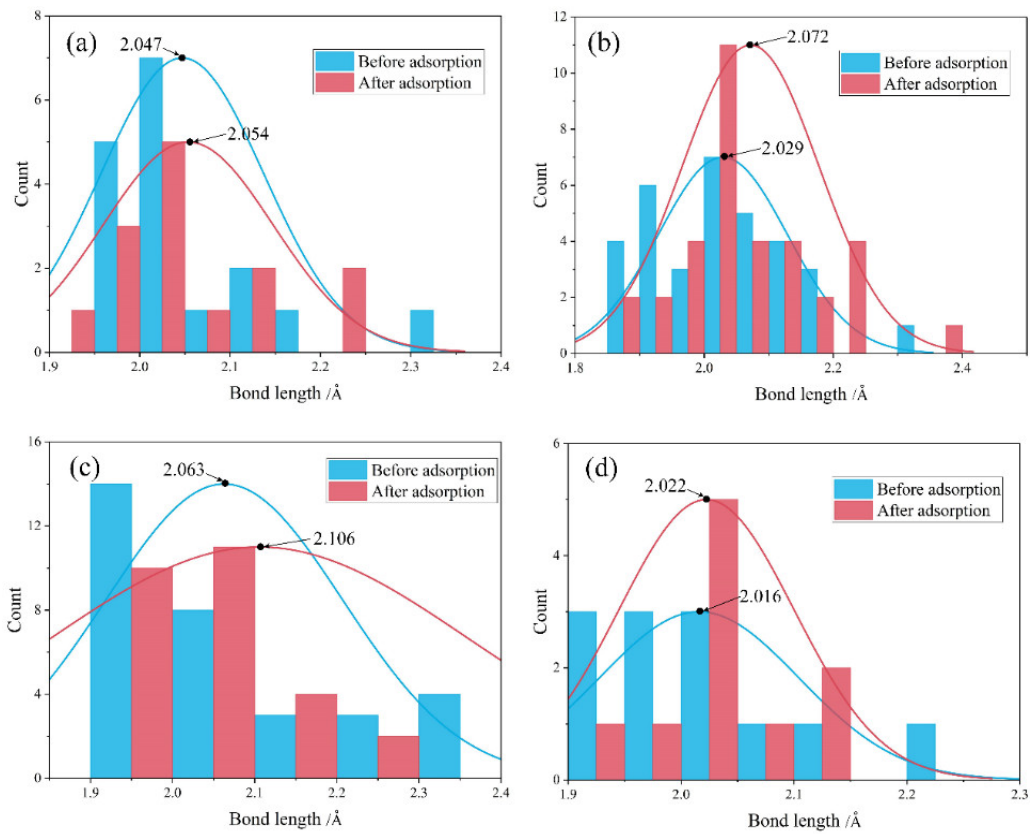
Figure 4. Distribution of surface Mg-O bond length that was involved in water adsorption: ( a ) dissociative adsorption on β-C 2 S surfaces, ( b ) molecular adsorption on β-C 2 S surfaces, ( c ) dissociative adsorption on β -C 2 S surfaces, ( b ) molecular adsorption on β -C 2 S surfaces, ( c ) dissociative adsorption on adsorption on M3-C 3 S surfaces, and ( d ) molecular adsorption on M3-C 3 S surfaces. M3-C 3 S surfaces, and ( d ) molecular adsorption on M3-C 3 S